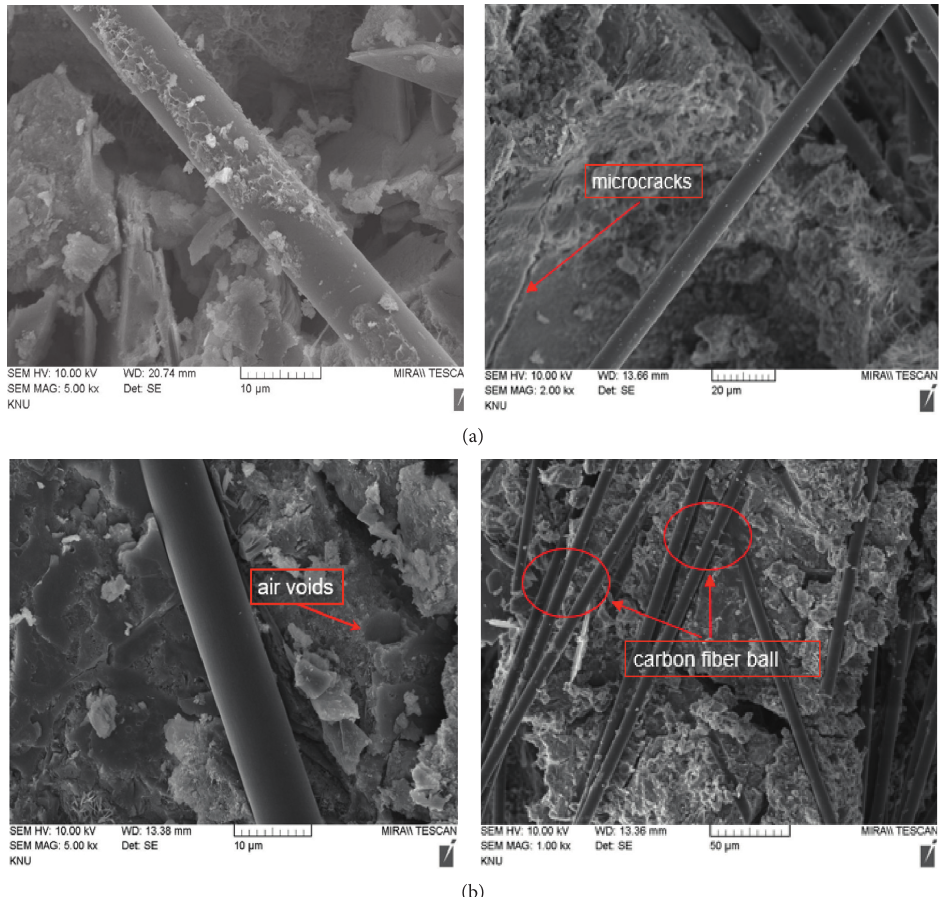
Figure 12: SEM images of CFRM composite specimens after strength tests (5000 or 1000 times): (a) SiO uncoated carbon